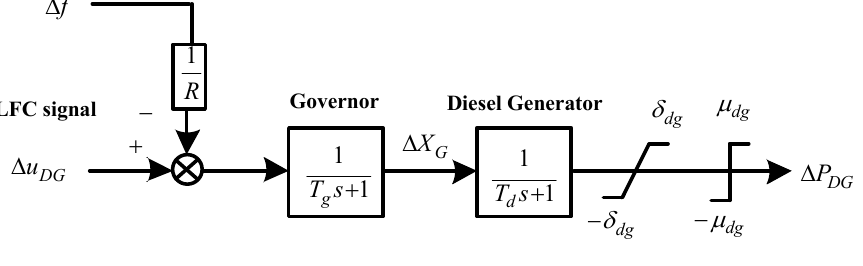
Figure 4. The transfer function model of DG for LFC